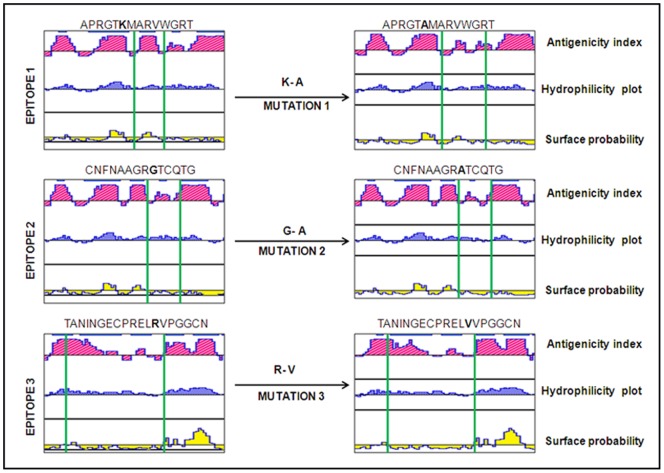
Comparative analysis of antigenic index of osmotin epitopes and its mutants by DNAstar protean system.The region between vertical lines show the three regions mutated by site directed mutagenesis. Mutation in epitope regions shows reduction in antigenic index in DNAstar program.